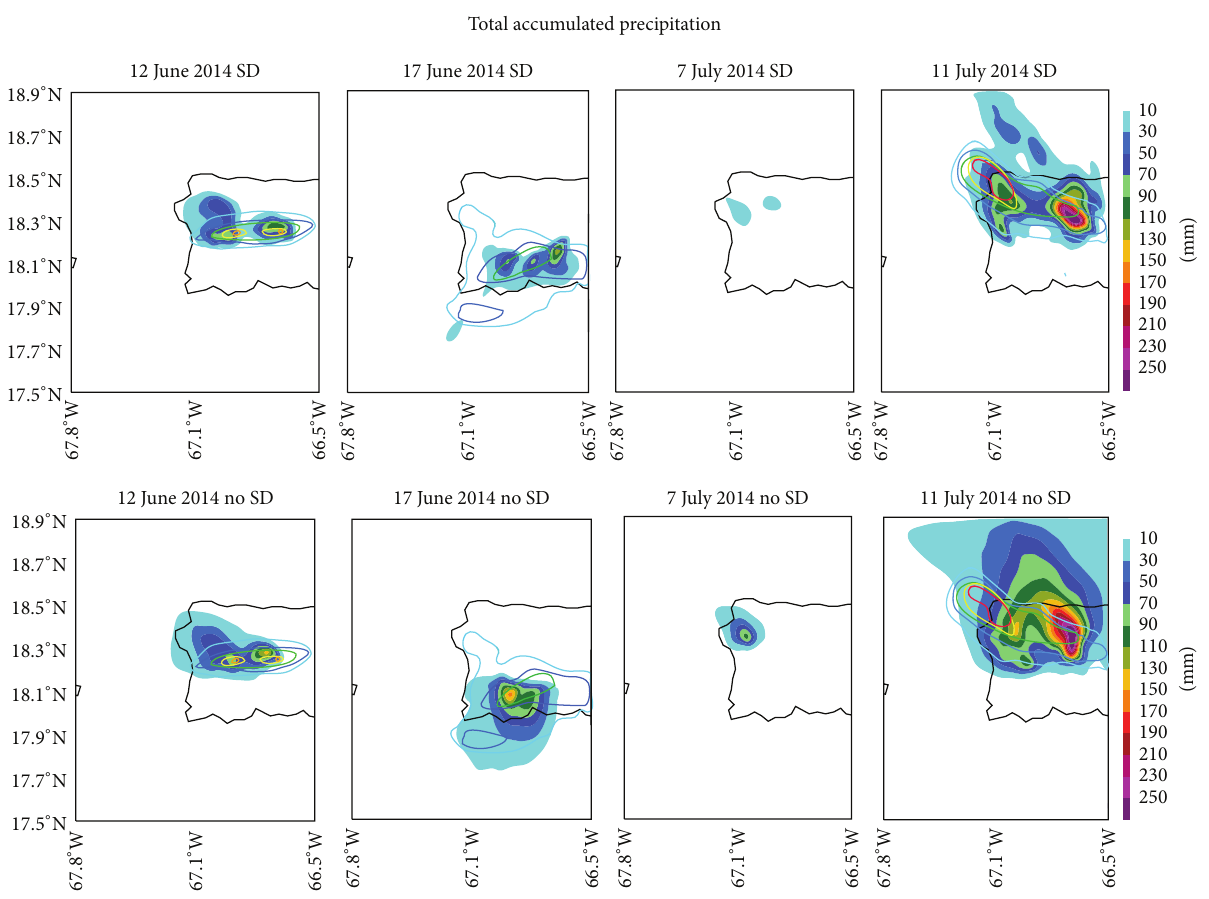
Figure 7: Total accumulated precipitation from RAMS (shaded) compared with NWS radar